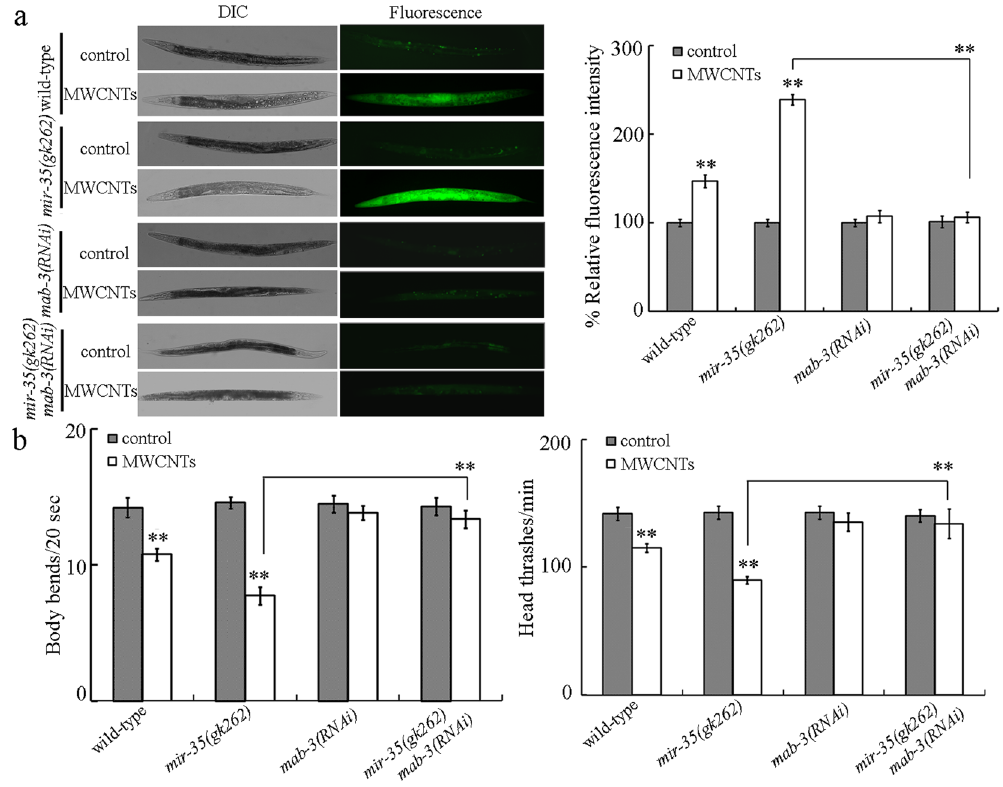
Figure 5. Genetic interaction between mir - 35 and MAB-3 in regulating the response to MWCNTs. ( a ) Genetic interaction between mir - 35 and MAB-3 in regulating the MWCNTs toxicity in inducing intestinal ROS production. ( b ) Genetic interaction between mir - 35 and MAB-3 in regulating the MWCNTs toxicity in decreasing locomotion behavior. MWCNT exposure concentration was 0.1 μ g/L. Bars represent means ± SD. ** P < 0.01 vs control (if not specially